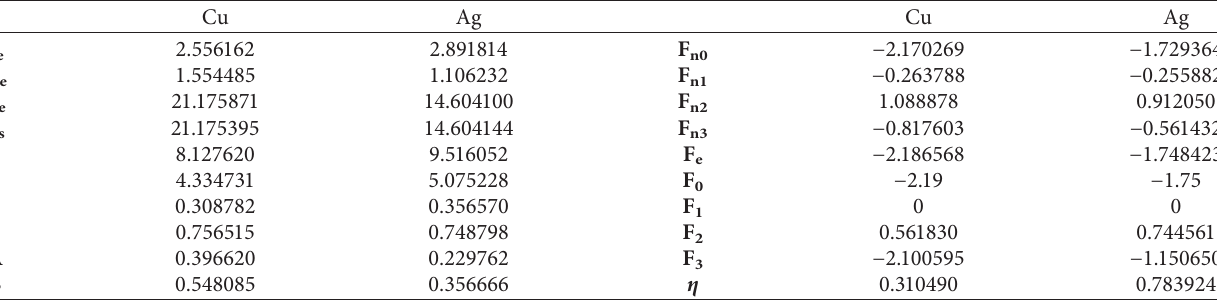
Table 1: Parameters for EAM